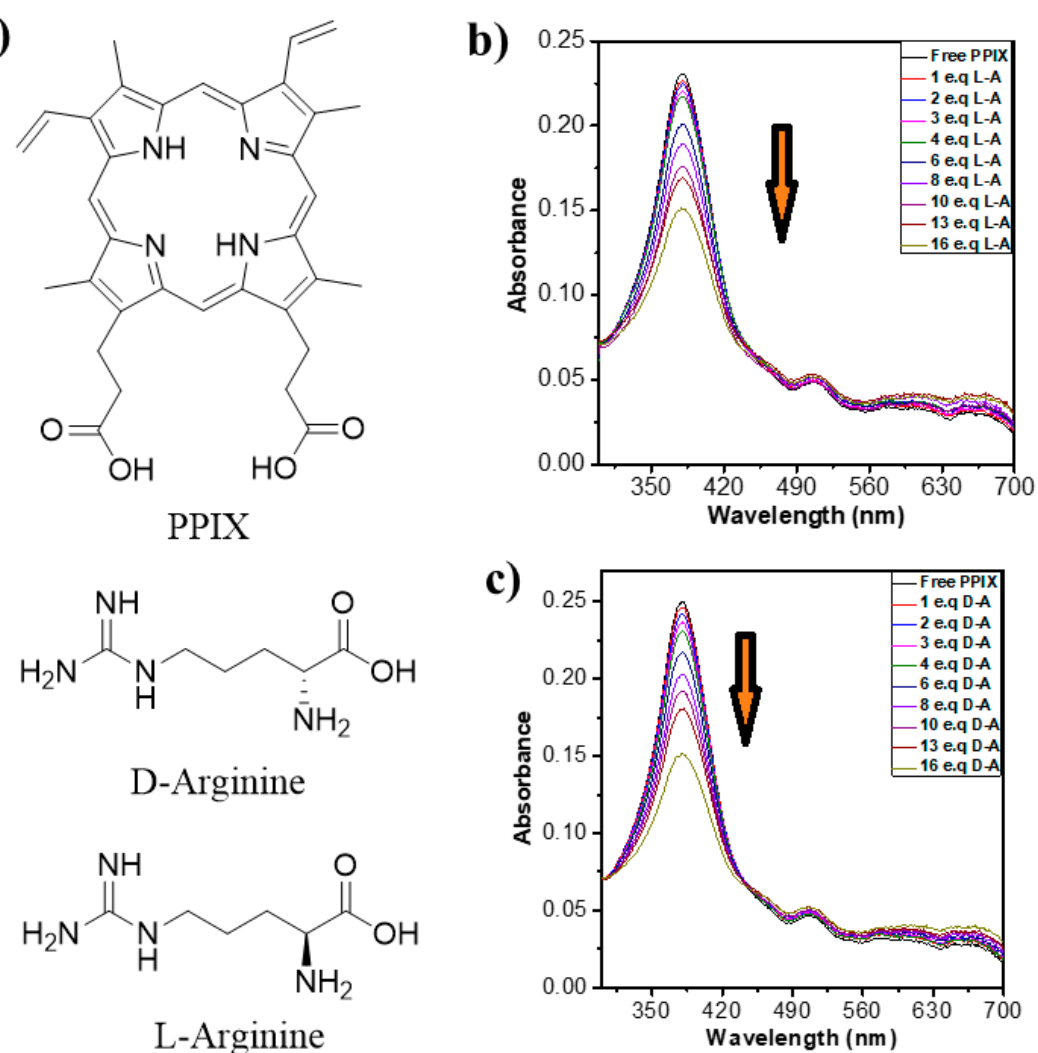
Figure 1. ( a ) Molecular structures of protoporphyrin IX (PPIX) and the d / l -arginine used in this study. Changes in UV-vis absorption spectra of PPIX (pH = 9) upon addition of (0–16 equiv.) l -arginine ( b ) and d -arginine ( c ).